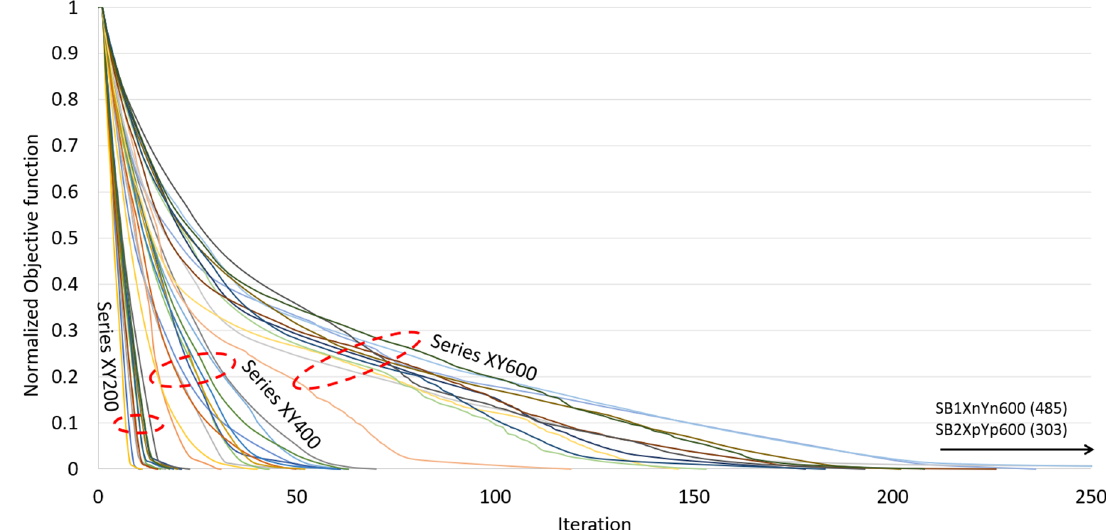
Figure 12. Convergence history for 36 shape change analysis cases in the bi ‐ directional mode for series XY200, XY400 and XY600.